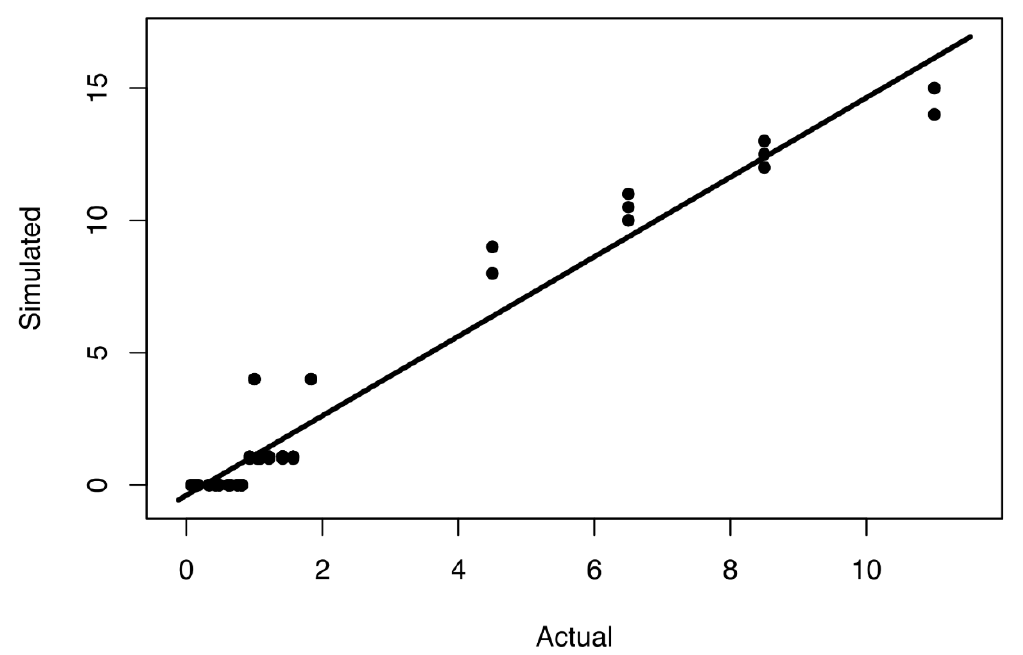
Figure 11. Model of relationship between simulated (SPRT) and actual (RT) recovery times as fraction of time granularity (TG).